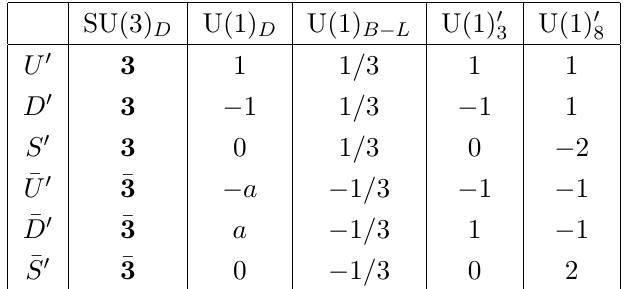
Table 3 . The charge assignment of the dark quarks for N f = 3 . The U(1) 0 are the two components of the Cartan subgroup of the vector-like SU(3) 0